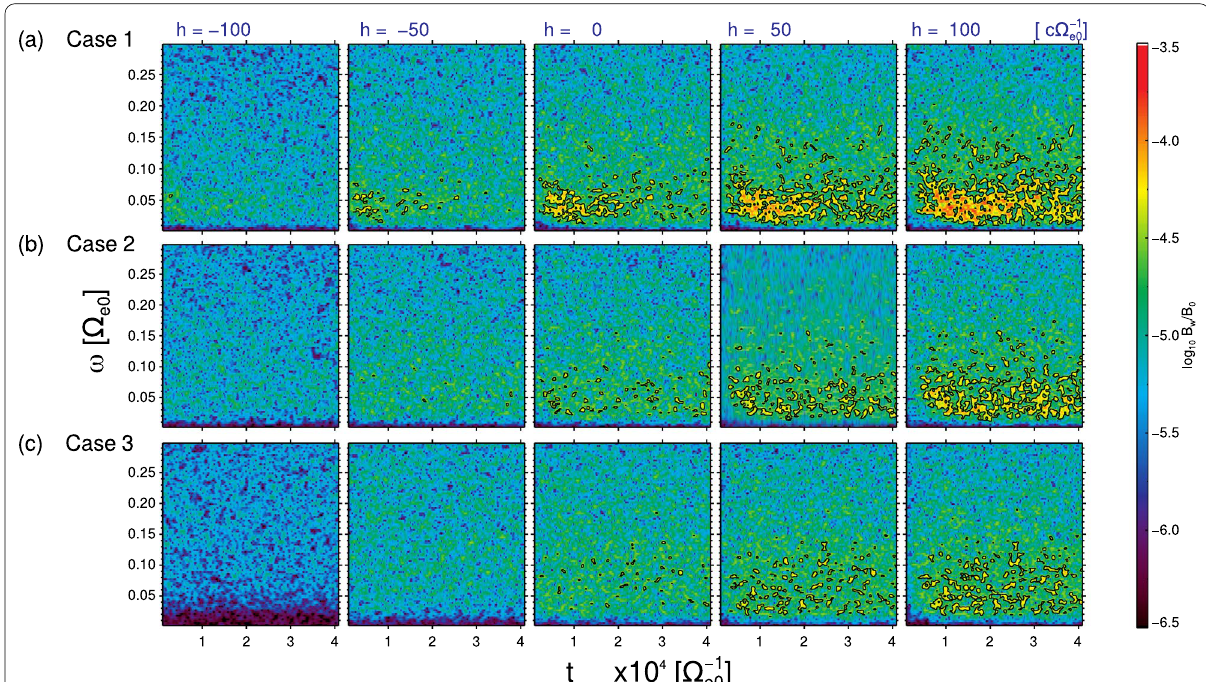
Fig. 5 Dynamic spectra of forward-propagating waves ( t = 0 ∼ 4.2 × 10 4 [ (cid:31) − 1 e 0 ] ) at locations of − 100, − 50,0,50,100 [ c (cid:31) − 1 e 0 ] , gradient coefficient a in three cases are a 1.87 × 10 − 7 (� e 0 / c ) 2 ; b 3.74 × 10 − 6 (� e 0 / c ) 2 , and c 3.74 × 10 − 5 (� e 0 / c ) 2 , respectively. Typical wave structures with amplitudes over 10 − 4.5 [ B 0 ] are